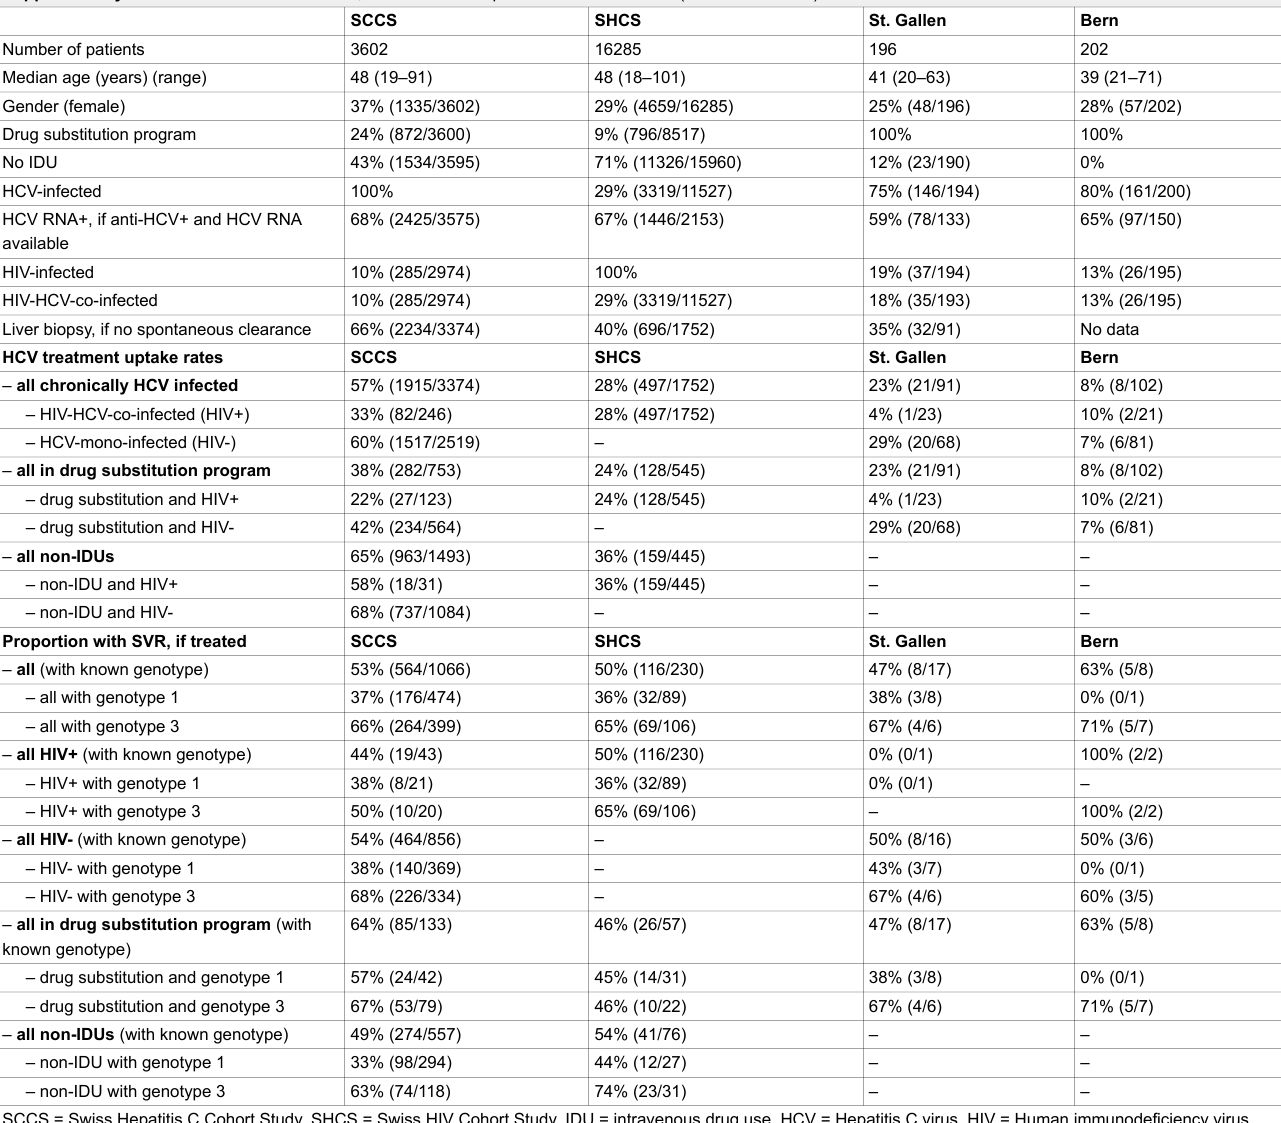
Supplementary table 2: Patient characteristics, HCV treatment uptake and success rates (extended version). SCCS